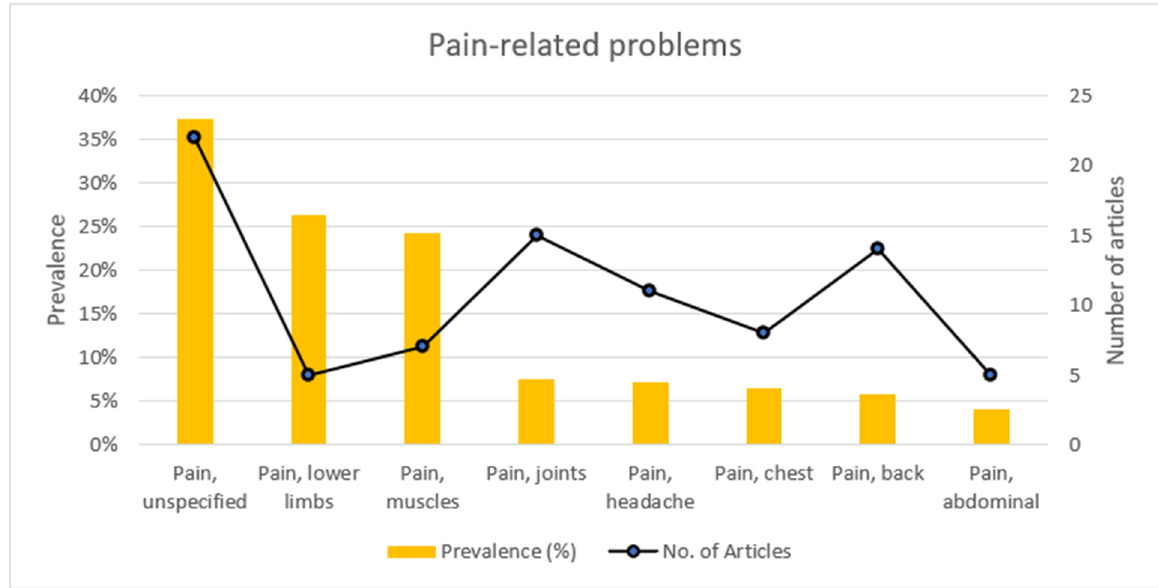
Figure 4. Prevalence of, and number of articles reporting on, pain-related problems.